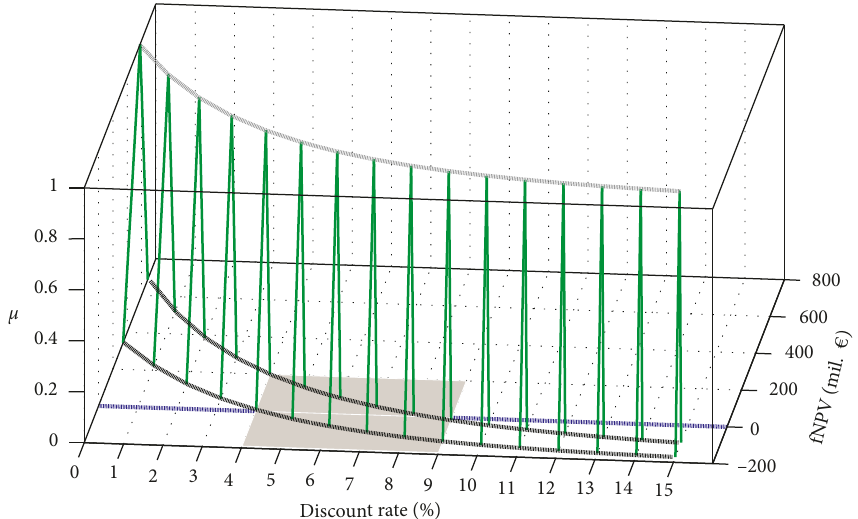
Figure 5: 3D plot of fNPV for various discount